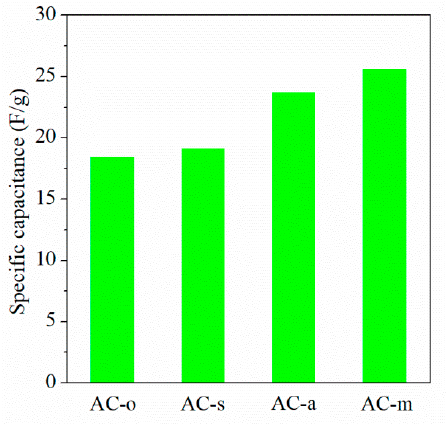
Figure 10. Specific capacitances of the samples in two-electrode system with the current load of 1